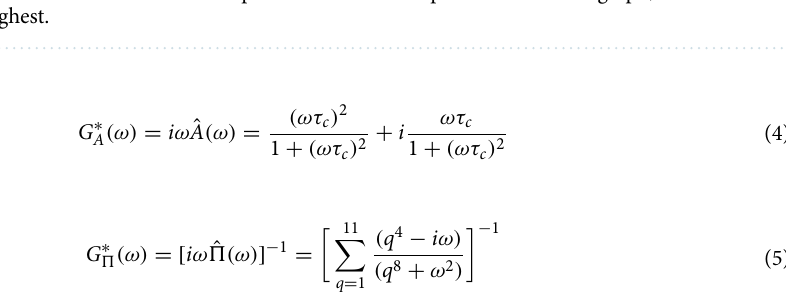
Figure 1. (Top) A single exponential decay function vs. time, representing the relaxation modulus of a single mode Maxwell fluid. (Bottom) A generic function resembling the normalised mean square displacement vs. time of an optically trapped particle suspended into a non-Newtonian fluid. Equations (2) and (3) are represented by a finite number of ‘sampled’ points and a continuous (pink) line. The points are also interpolated by means of three MATLAB built-in interpolation functions: Spline, PCHIP and Makima. The insets show the relative absolute error of each interpolation function with respect of either of Eqs. (2) and (3), as calculated using Eq. (7). The time window of the inset encompasses the final three points of the main graph, where the relative error is at its